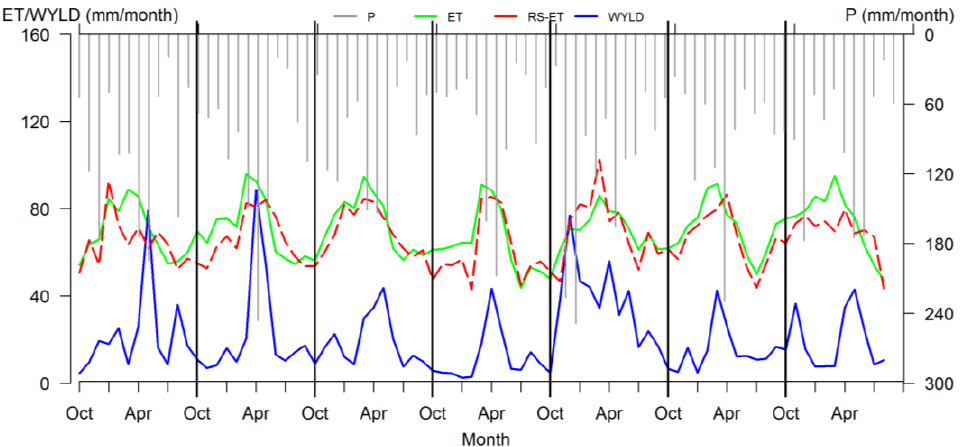
Figure 18. The monthly water balance dynamics for 2002–2009 over the Mara Mines watershed (W6) as simulated by SWAT. The months are arranged according to the hydrological year (Oct – Sept).